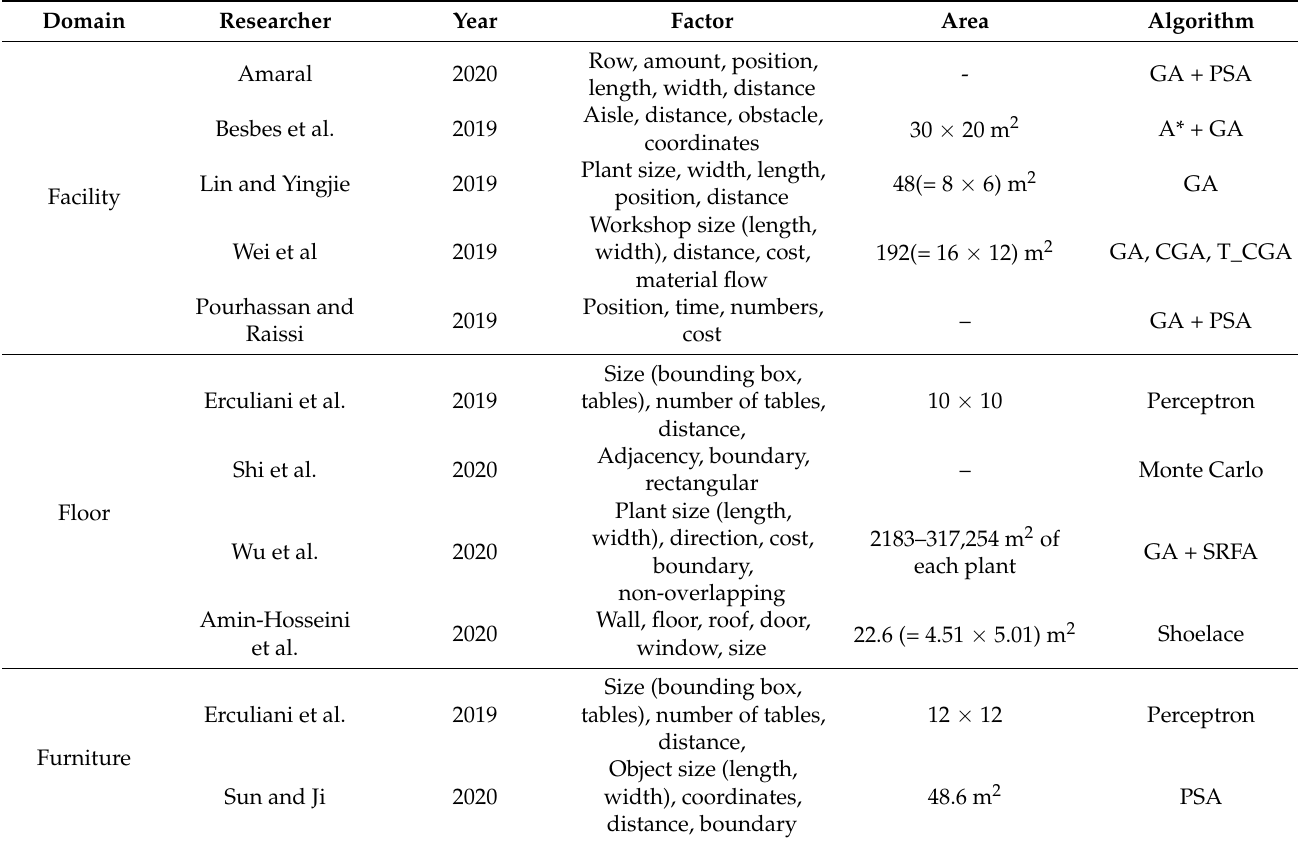
Table 5. Genetic algorithm application in some spatial layout